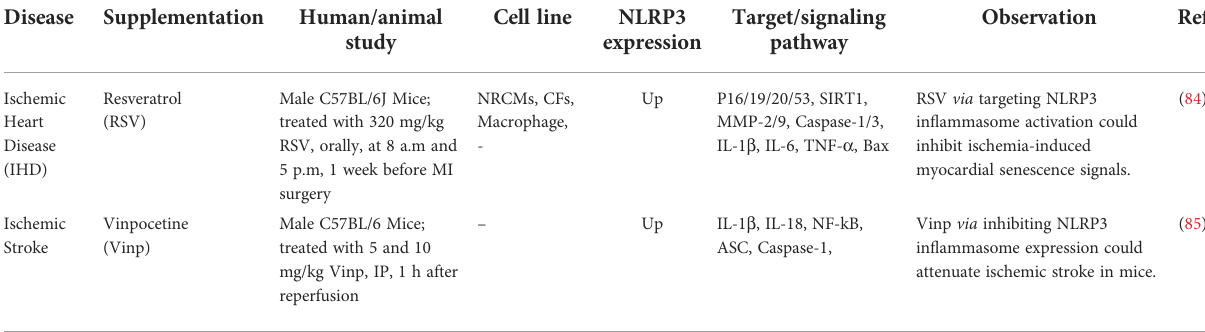
TABLE 4 Role of NLRP3 in other types of I/R